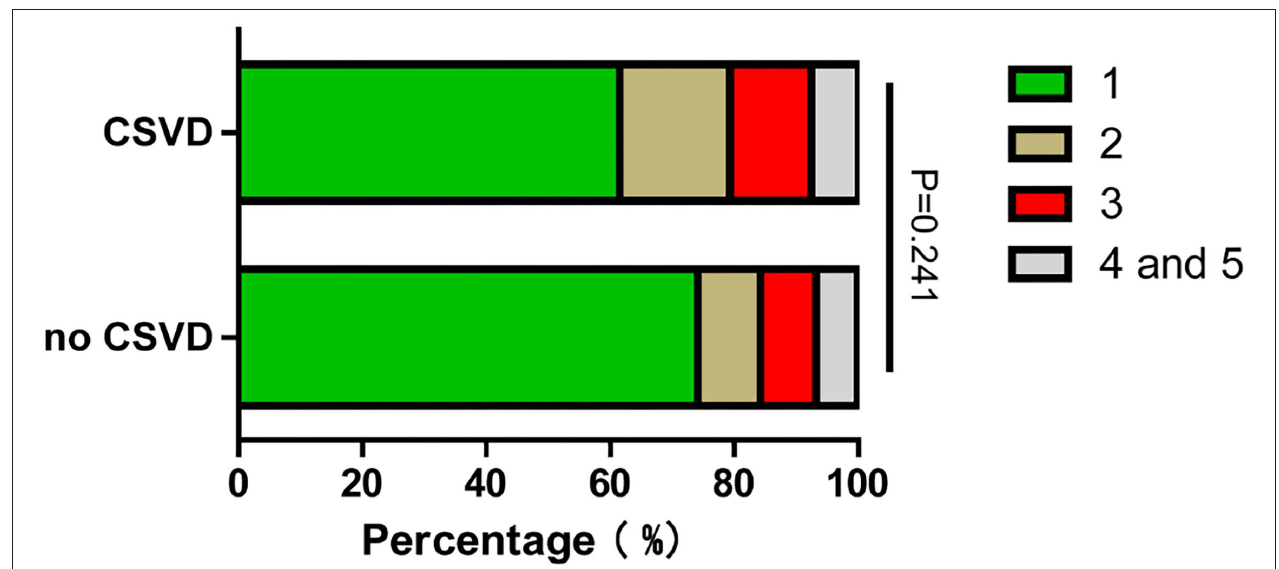
FIGURE 4 | TOAST classification distribution of no CSVD and CSVD groups. TOAST classification: (1) Large artery atherosclerosis. (2) Cardioembolism. (3) Small-artery occlusion. (4) Stroke of other determined cause. (5) Stroke of undermined